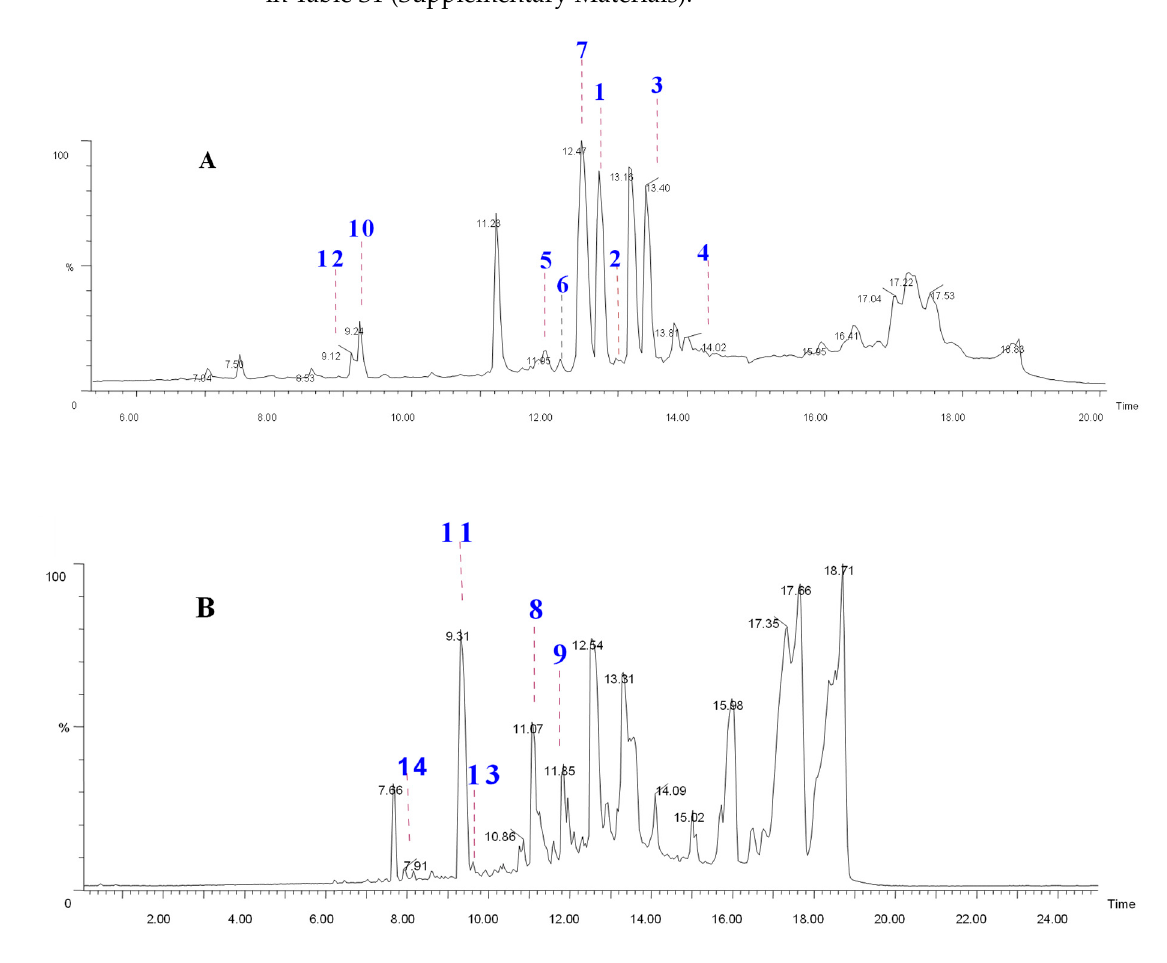
Figure 1. TIC of ( A ) R. conduplicans acetone extract and ( B ) enriched fraction-4. Based on the fragmentation of isolates, we have identified compounds ( 1 – 5 ) and ( 7 – 9 ) along with atranorin belonging to depsides. The literature clearly indicates that sekikaic acid is an abundant molecule in Ramalina species [19]. Sekikaic acid ( 1 ) is a m -depside corresponding to the esterification of two divaricatinic acid units and is found with Rt at 11.98 min and m / z 417.1547 (C 22 H 25 O 8 ) with fragments m / z 209 and m / z 225 corre- sponding to the A ring and B ring, respectively [20]. Compounds 1 , 3 , 5 , 7 , 8, and 9 , having a common fragment m / z 209 (Figures S47 and S48, Supplementary Materials), clearly indicate the difference in locating the other Bring. These depsides can be considered as ester derivatives of divaricatinic acid ( 11 ) while compound 2 is a divaric acid derivative (recognized at Rt 7.50 min, m / z 195.0657). The other identified monoaromatic compounds correspond to 2,4-di- O -methyldivaric acid ( 6 ), 4- O -methyldivaricatic acid ( 10 ), divaricatinic acid ( 11 ), olivetolic acid ( 12 ), divarinolmonomethylether ( 13 ), and atranol ( 14 ). In this run, three additional compounds were ionized and fragmented (Rt = 8.53 min, Rt = 11.88 min, and Rt = 13.17 min) and not determined. The fragmentation feature of Compound 5 ( m / z 401.1954 [M − H] − (calcd. for [C 23 H 28 O 6 ] − 401,1964)) suggested the coupling of a divar- icatinic acid moiety to an olivetol monomethylether moiety (Figure S17, Supplementary Materials). Based on these fragmentation studies, we assigned compounds as shown in the Supporting Information section and in Table S1, including the monoaromatic divaric acid, along with the common and already-described atranorin (depside), usnic acid (related